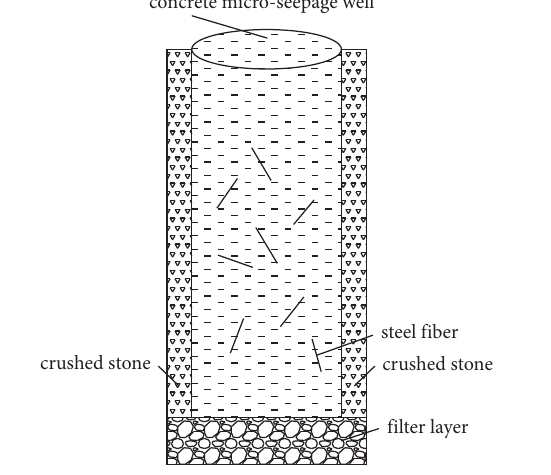
Figure 1: Schematic representation of a concrete microseepage well.